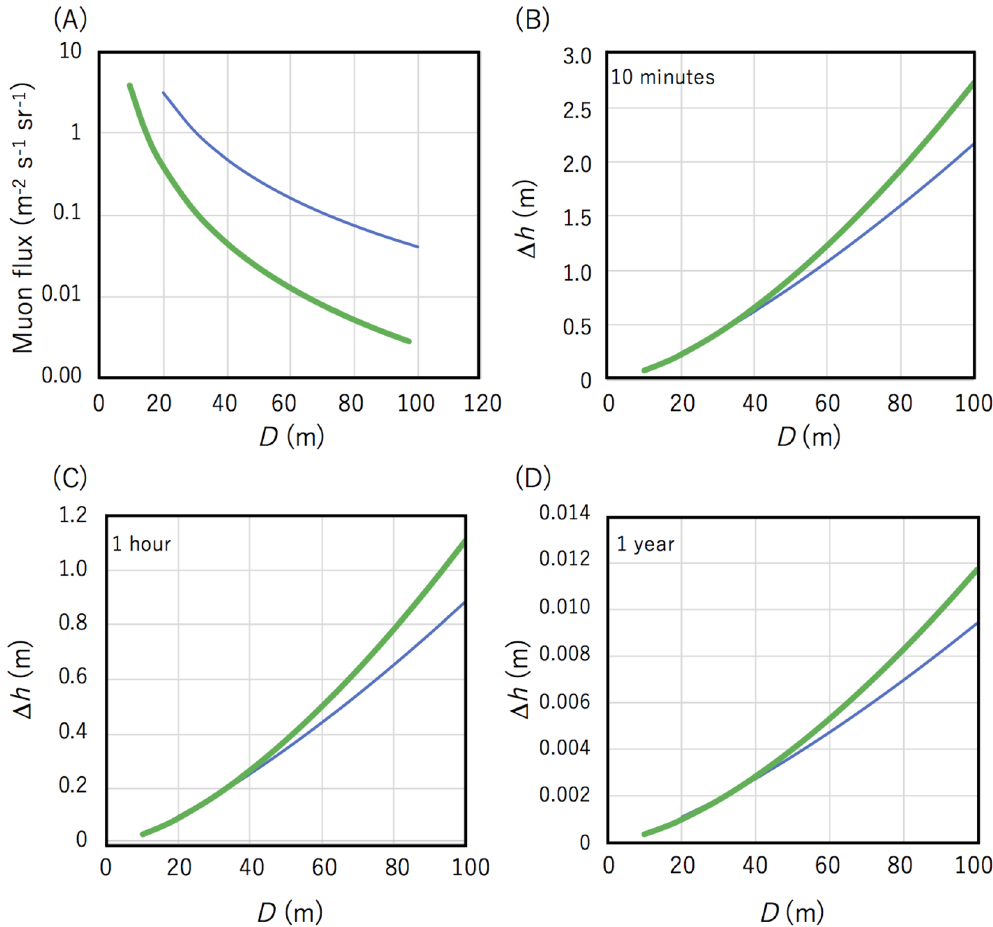
Figure 10. Muon flux ( A ) and detectable tide level variations ∆ h ( B , C ) as a function of the distance between the MSM and the shoreline ( D ) for ( d - H ) = 5 m (blue lines), and ( d - H ) = 15 m (green lines), where the detectable ∆ h was defined by the standard deviation of the muon flux. The detectable ∆ h variations are shown for different time resolutions: 10 min ( B ), 1 h ( C ), and 1 year ( D